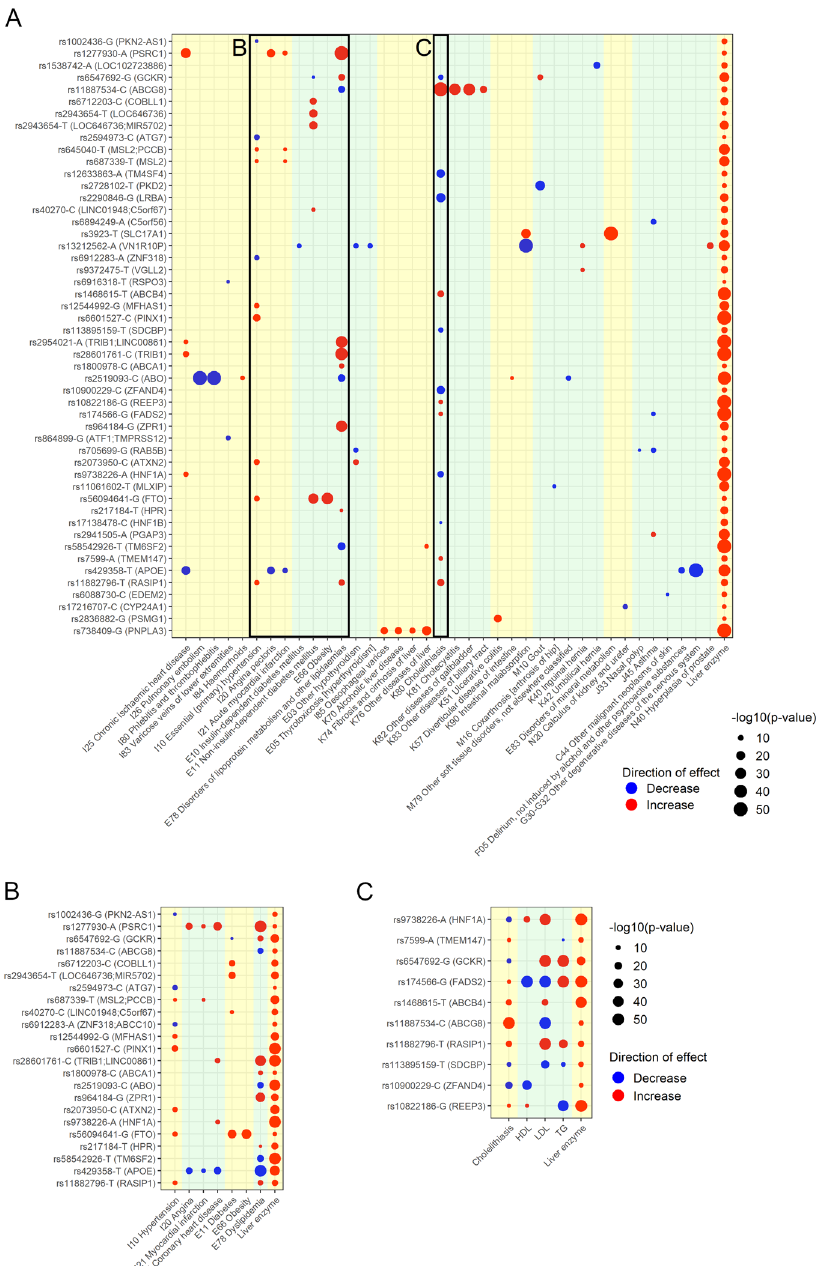
Fig. 4 Phenome-wide association study of liver enzyme associated variants. A All associations between liver enzyme-associated variants and diseases. B Associations between liver enzyme-associated variants and metabolic diseases. C Associations between liver enzyme-associated variants, cholelithiasis, and lipid traits, namely high-density lipoprotein (HDL), low-density lipoprotein (LDL), and triglycerides (TG). For all panels, only genome wide-signi fi cant associations (unadjusted p <5 ×10 − 8 ) are shown. Red indicates that the liver enzyme-increasing allele increases the disease/trait, while blue indicates that it decreases it. Larger circles indicate lower p -value. Background shade denotes organ system associated with the diseases. Data for A and B are from 22 while data on HDL, LDL, and TG are based on genome-wide association studies in UK BioBank. B and C use the same scale while A uses a different scale. When more than one variant at a given locus (i.e. <1 MB apart) was associated with different liver enzymes, only the variant with the most signi fi cant association with a liver enzyme was included. (For example, if one variant was associated with alanine aminotransferase with p = 4×10 − 8 and another nearby variant was associated with aspartate aminotransferase with p = 2×10 − 8 , the latter would be used.) Note that rs5854926 ( TM6SF2 ) had opposite effects on alanine aminotransferase and alkaline phosphatase and on this plot is aligned to the alanine aminotransferase-increasing allele. A two-sided Z statistic was used.